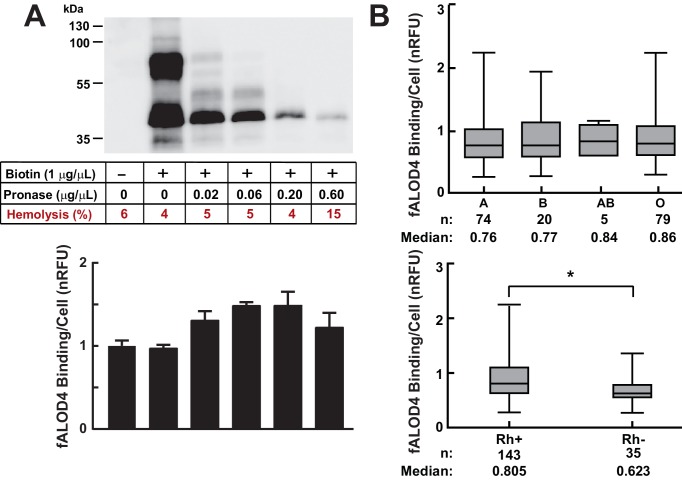
Effects of cell surface proteins on fALOD4 binding to RBCs.(A) Effect of proteolysis of RBC surface membrane proteins on fALOD4 binding to RBCs. RBCs isolated from a healthy individual were labeled with biotin and then treated with increasing amounts of pronase as indicated. An aliquot of the treated RBCs was used for fALOD4 binding assays and the remainder was subjected to 10% SDS/PAGE and probed with streptavidin-HRP (0.22 µg/mL) as described in the Materials and methods. fALOD4 binding values were normalized to the untreated sample. Data points represent the mean of three independent measurements. Error bars represent the SEM. The experiment was repeated three times and the results were similar. (B) Relationship between fALOD4 binding and ABO blood group antigens (upper panel) and Rhesus blood group (Rh antigen) (lower panel). RBC fALOD4 binding was determined in triplicate using RBCs from 178 White blood donors as described in the Materials and methods. Each fALOD4 binding measurement was performed in triplicate and values were normalized to the reference blood sample. Boxes represent the 25th and 75th percentiles and whiskers represent the minimum and maximum measurements. *p<0.005, two-tailed t-test. nRFU, normalized relative fluorescence units.